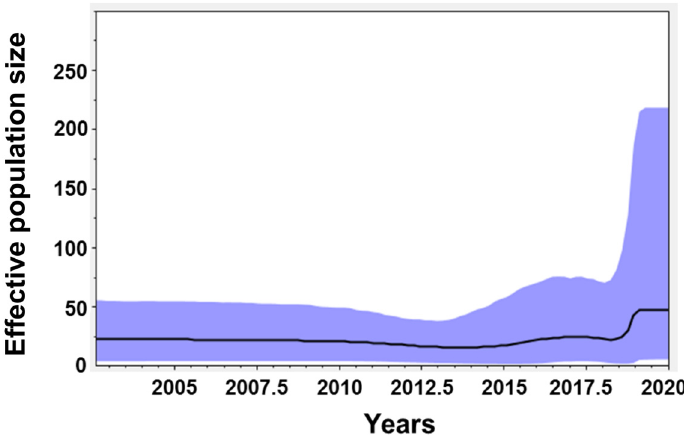
Figure 2. Skyline population analysis of wild Korean boars infected with CSFV. CSFV skyline pop- ulation analysis of wild Korean boars from 2002 to 2020. The black line denotes the mean level for the effective population size, and the shaded blue region represents the high and low levels for the effective population size.